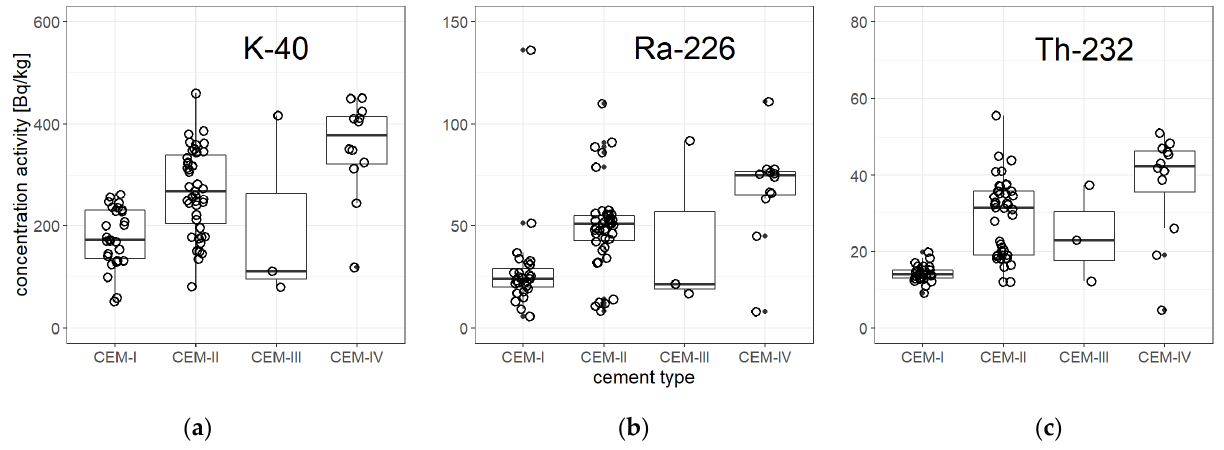
Figure 3. Box-whisker plots for the concentration of potassium ( a ), radium ( b ), and thorium ( c ). Box-plots present the basic values of descriptive statistics: the median (horizontal line), the first and the third quantile (bottom and top side of the box, respectively), the maximum and minimum values not considered an outlier (upper and lower whisker border, respectively), and outliers and extreme values. The figure contains separate boxes for different cement types as to extract statistical differences between these groups, if exist. All the collected data, both from other studies and the measurements of the authors of this study, were used to prepare the above charts.